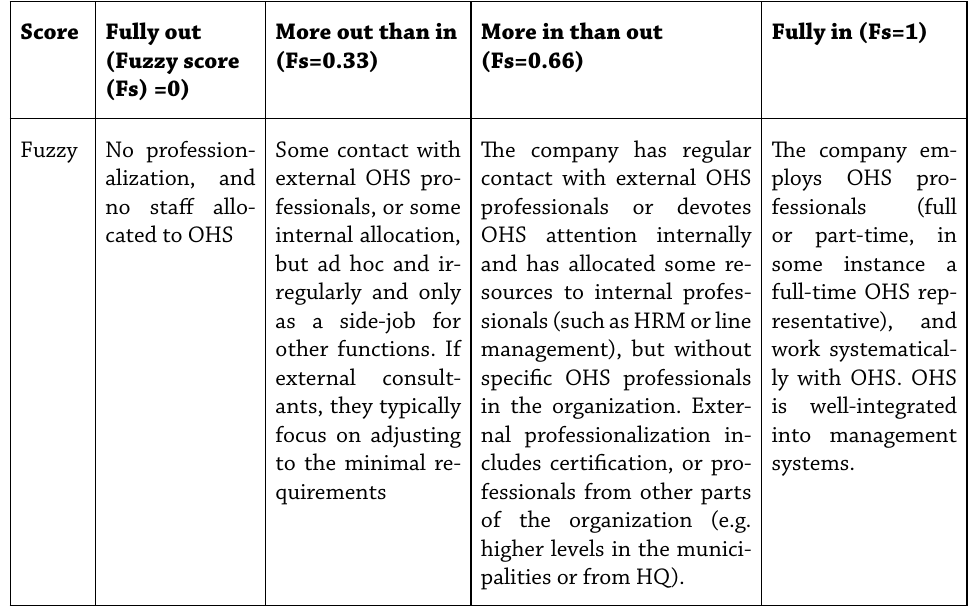
Table 3: Calibration of professionalization of OHS Score